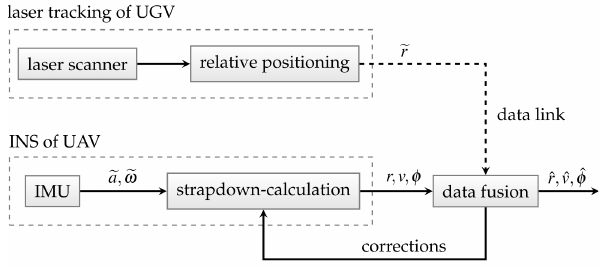
Figure 5: Integration method of the laser scanner based relative positioning system